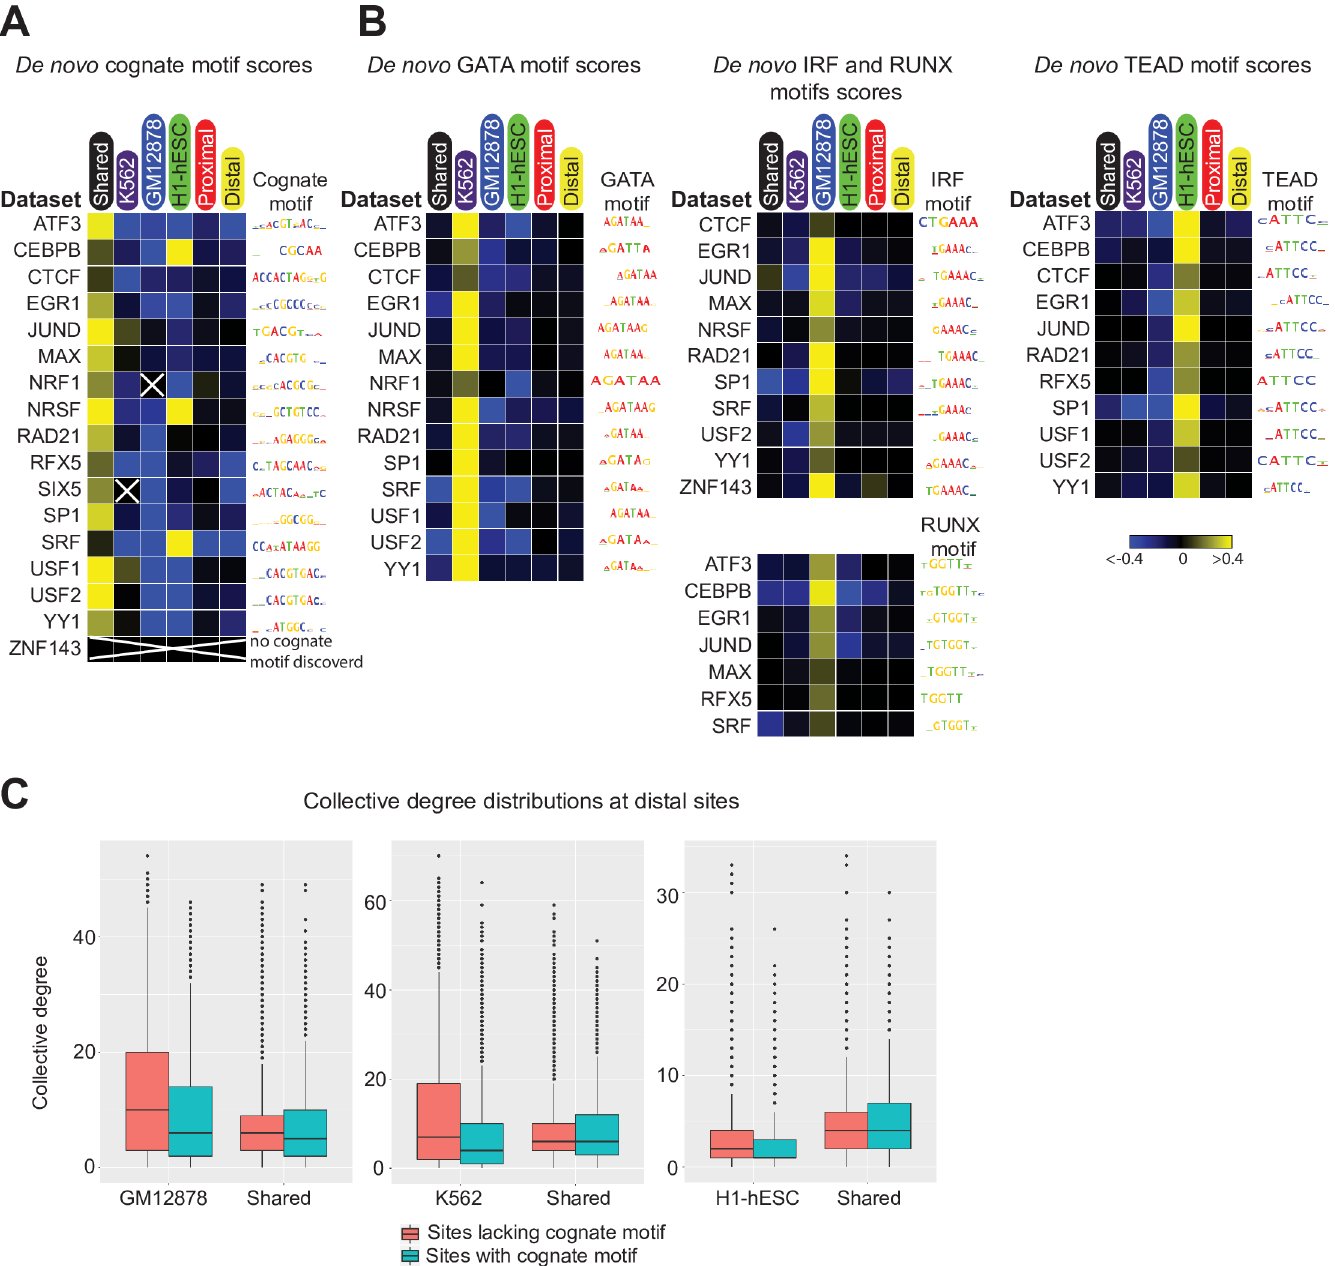
Fig 5. SeqUnwinder analysis of sequence features at multi-condition TF binding sites for 17 ENCODE TFs. (A) Label-specific scores of de novo discoveredcognatemotifs across all 17 ENCODE TF datasets. SeqUnwinder did not discover a cognatemotif for ZNF143. GM12878-enriched sites for NRF1 and H1-hESC-specific sites for SRF were excludedbecauseof low number of bindingsites. (B) Label-specificscores of de novo discovered GATA- like, IRF-like, RUNX-like and TEAD-like motifs. (C) Collectivedegreedistributionsat distal sharedand cell-specific sites further stratified basedon presence of cognatemotif. For consistencyacross figures, we fix the color saturation values to -0.4 and 0.4.